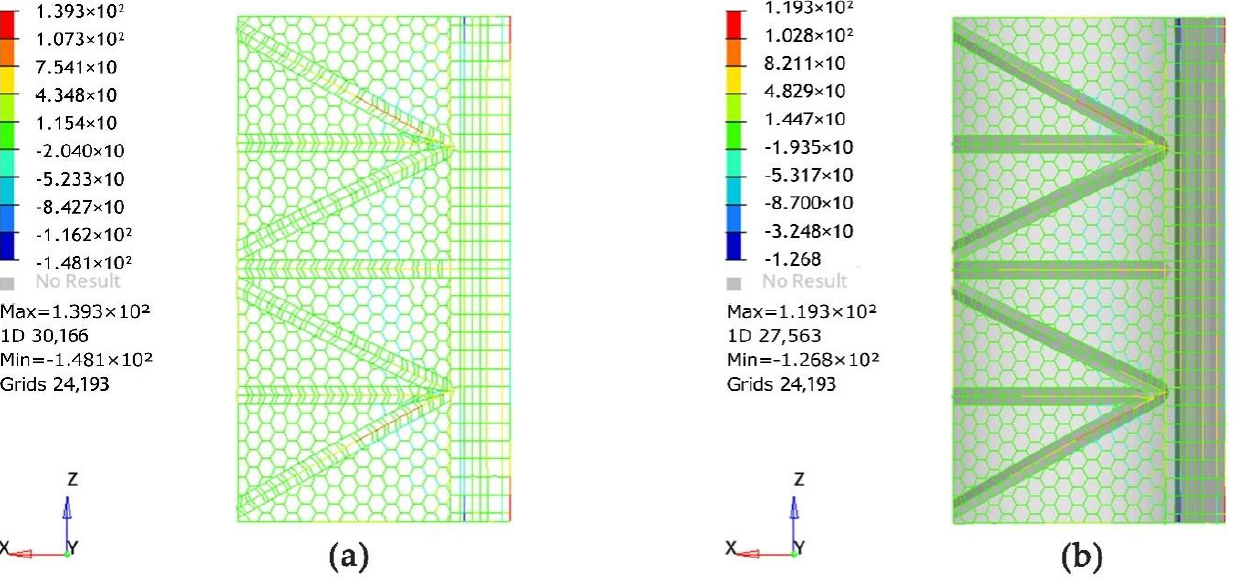
Figure 13. Numerical plots of deflection of model II under permanent load plus external load. ( a ) Deflection diagram of model II skeleton under self-weight plus external load. ( b ) The maximum deflection of model II skeleton with membrane cloth under self-weight plus external load.